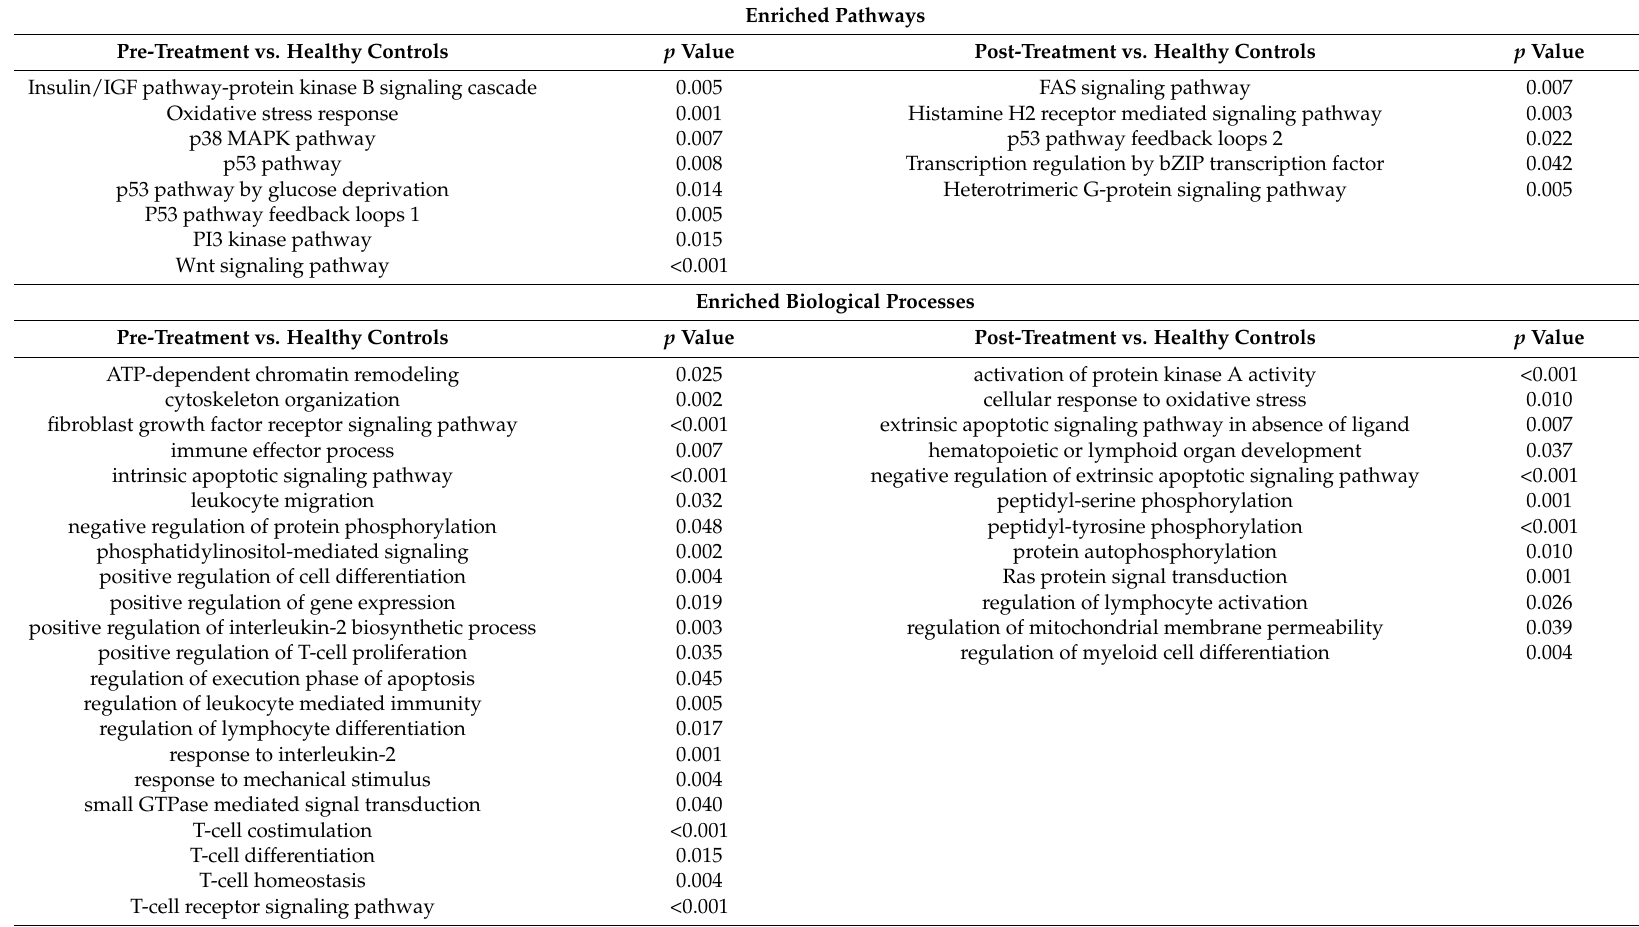
Table 3. Pathways and biological processes that were enriched only pre- or post treatment. Enriched